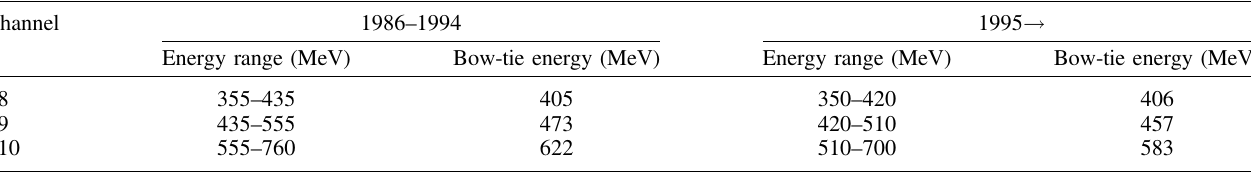
Fig. 1. Use of data from different GOES satellites over time shown (coloured horizontal bars), along with the SEP episodes (gray vertical Table 1. Nominal energy ranges and bow-tie energies of differential HEPAD channels P8 – P10. Nominal energies taken from Panametrics, Inc. (1986) and Space Systems/Loral (1996).